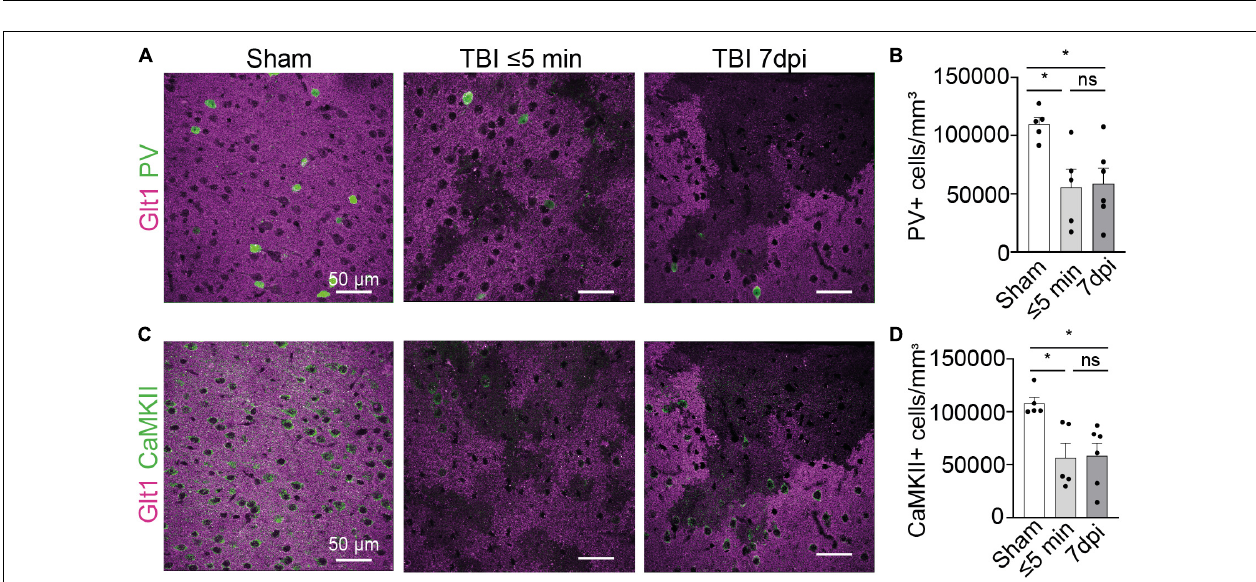
FIGURE 1 | ANOVA: significant, p -value = 0.0047. Post-hoc analysis (Tukey HSD): Sham vs. ≤ 5 min: p < 0.0111; Sham vs. 7 dpi: p < 0.0091; ≤ 5 min vs. 7 dpi: p < 0.9808. Statistics for nuclear NeuN+ cells (Sham: 68,063 ± 6,018, n = 6; ≤ 5 min: 29,466 ± 8,146, n = 5; 7 dpi: 21,056 ± 2,864, n = 7). One-way ANOVA: significant, p -value ≤ 0.0001. Post-hoc analysis (Tukey HSD): Sham vs. ≤ 5 min: p < 0.0008; Sham vs. 7 dpi: p < 0.0001; ≤ 5 min vs. 7 dpi: p < 0.5527. (E) Three different patterns of NeuN expression were observed when quantifying NeuN. Normal expression of NeuN showed consistent bright and vibrant expression in the nucleus of the neuron. Faint expression of NeuN showed a decrease of expression in the Nucleus of the neuron. Mislocalized expression of NeuN show little to no expression of NeuN in the nucleus but expression within the cytoplasm of the cell. Cells were quantified in regions of atypical astrocytes and in neighboring healthy astrocytes and graphed. Inside ROI’s Sham’s cells were 100% normal neurons, in ≤ 5 min cells were 41% Normal, 35% faint, and 24% mislocalized. In 7 dpi cells were 24% Normal, 31% faint, and 45% mislocalized. Outside ROI’s Sham’s cells were 100% normal neurons. In ≤ 5 min cells were 66% Normal, 16% faint, and 18% mislocalized. In 7 dpi cells were 58% Normal, 17% faint, and 25% mislocalized. (F) Magnified image of “normal,” “faint,” and “mislocalized” NeuN expression and the corresponding Nissl images. Yellow arrowheads point to faint NeuN expressing neurons and white arrowheads point to mislocalized neurons.